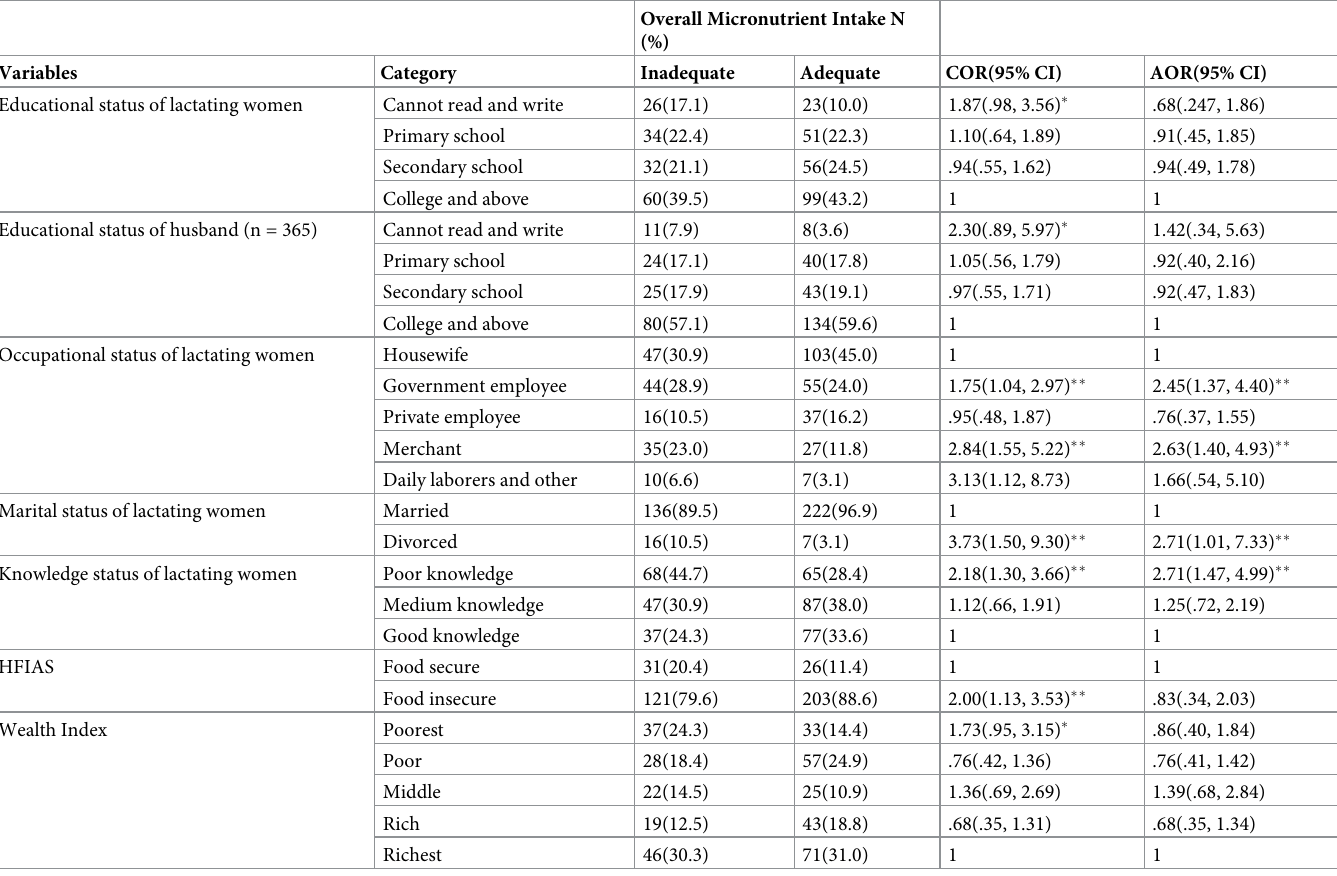
Table 4. Bivariable and multivariable binary logistic regression analysis of overall micronutrient intake inadequacy among lactating women in Bahir Dar city, Northwest Ethiopia, 2021(n =